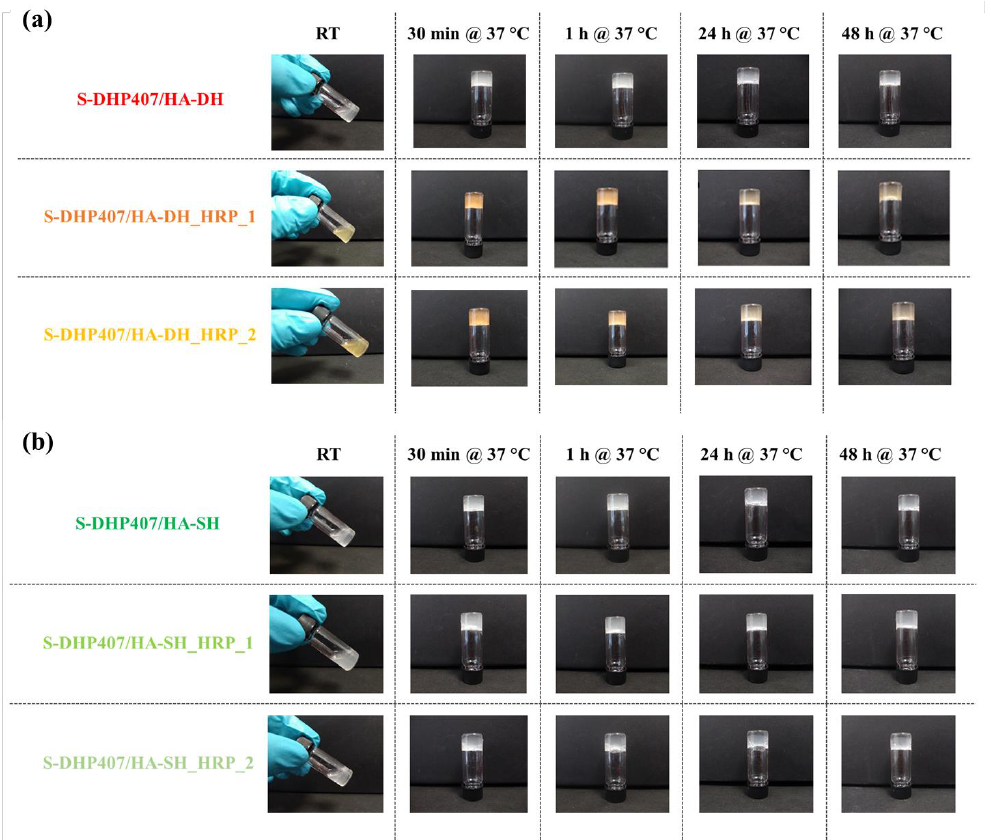
Figure 8. Representative photos of the tube-inverting test applied to ( a ) S-DHP407/HA-DH, S-DHP407/HA-DH_HRP_1 and S-DHP407/HA-DH_HRP_2, and ( b ) S-DHP407/HA-SH, S-DHP407/HA-SH_HRP_1 and S-DHP407/HA-SH_HRP_2 bioartificial samples at different tempera- tures and time points: immediately after preparation at room temperature (RT) and at 30 min, 1 h, 24 h and 48 h incubation at 37 °C.